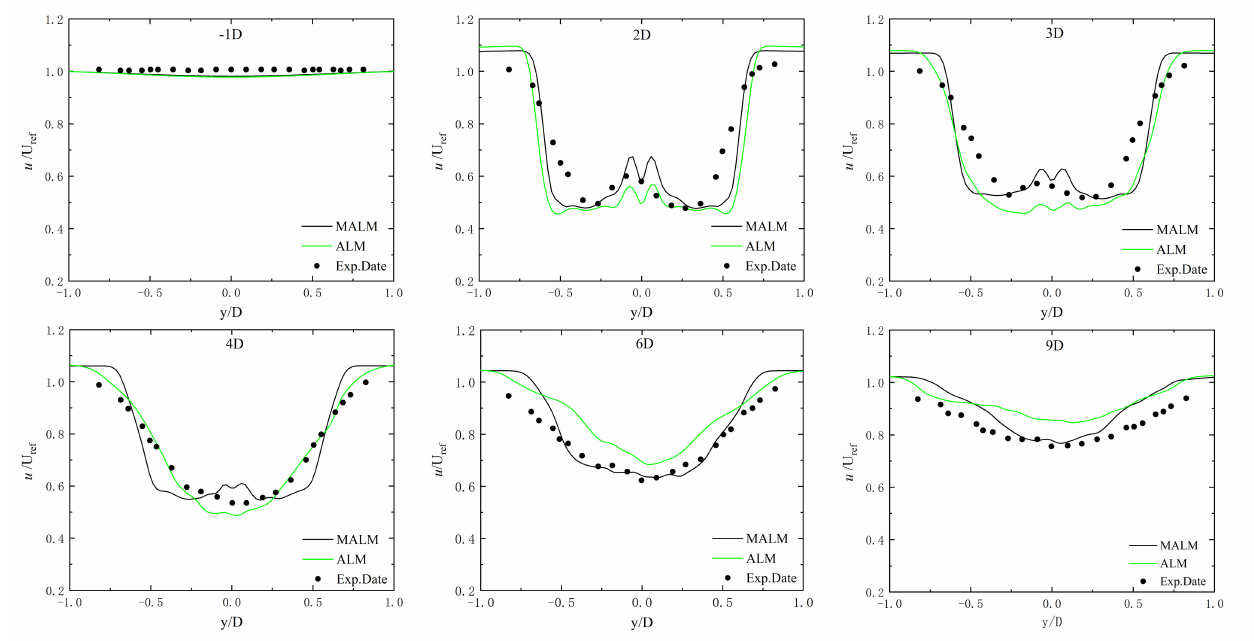
Figure 6. Average wake velocity profiles in different locations at the hub height. The black points rep- resent the experimental data [33] (U ref = 5 m/s). Reprint with permission 5219051009765; Copyright 2018,